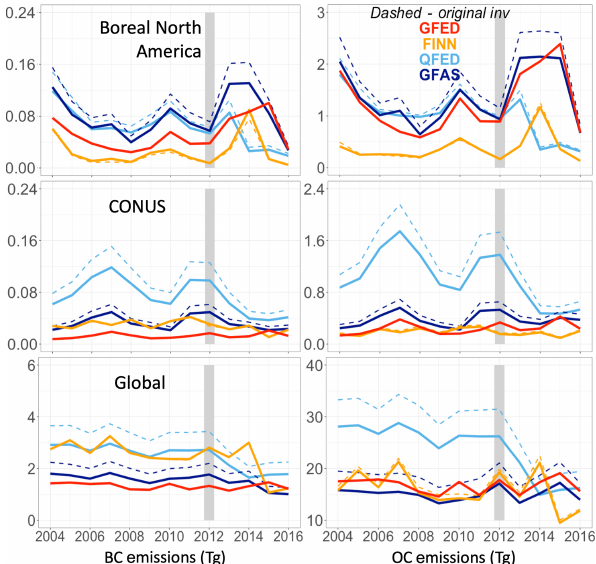
Figure 5. Annual emissions scaled to GFED4s emissions factors from 2004 to 2016. The original inventory emissions from FINN1.5 (orange), QFED2.4 (light blue), and GFAS1.2 (dark blue) are shown as dashed lines, while their annual values using GFED4s (red) emis- sions factors are shown as solid lines. The year 2012 is marked with a gray